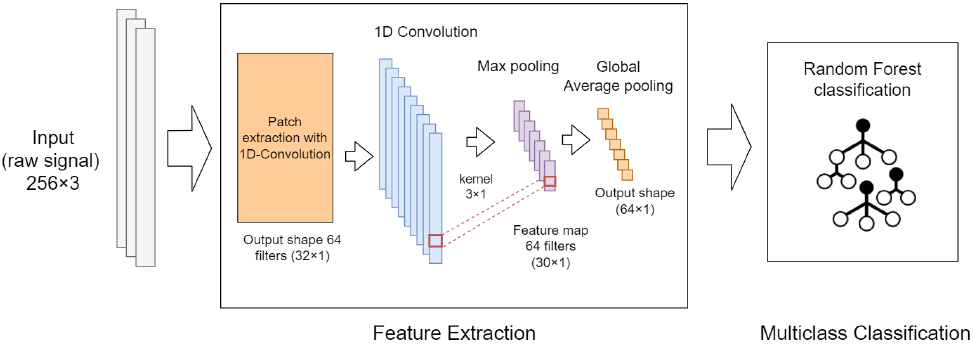
Figure 7. Proposed architecture for a CNN with patch input and Random Forest